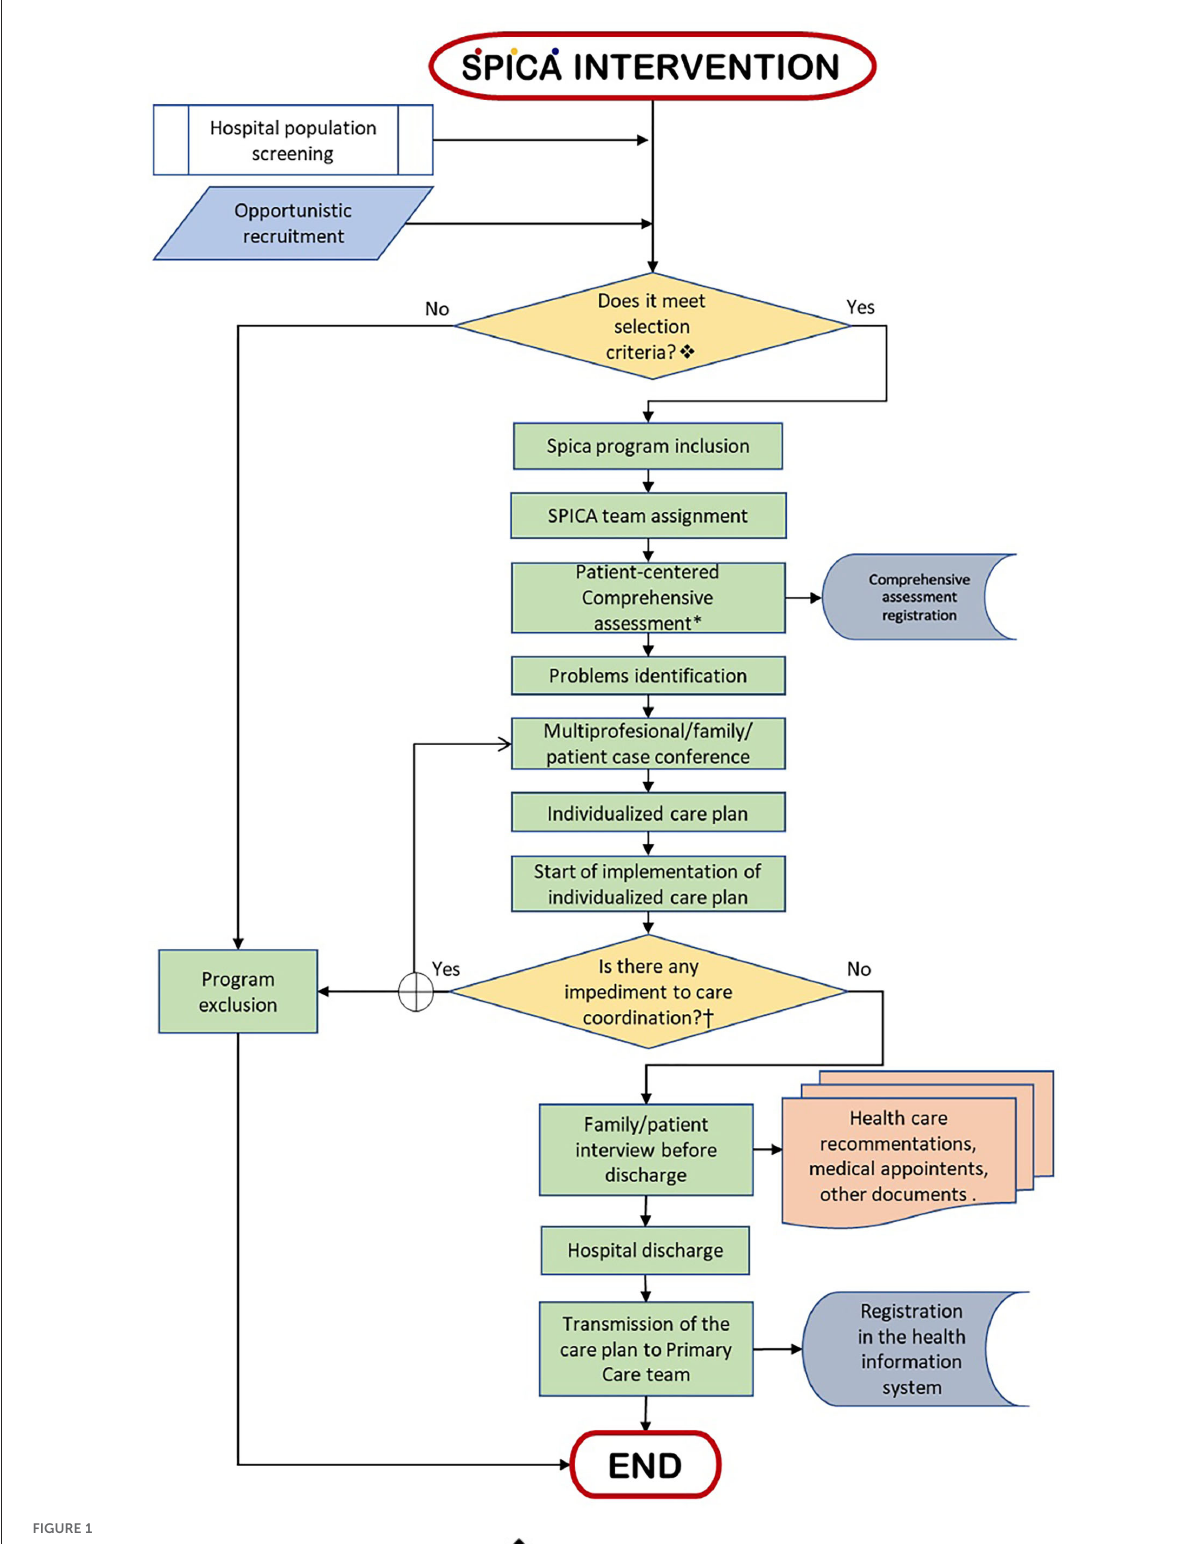
Flowchart (summarized) of the SPICA intervention process. Inclusion criteria of the SPICA program are described in Table 1. *The sections that make up the SPICA comprehensive assessment are described in Supplementary Annex I. † Circumstances that do not allow the care coordination for patients included in SPICA program are: transfer of patients to other hospital or an intermediate care facility; death; or patient/family